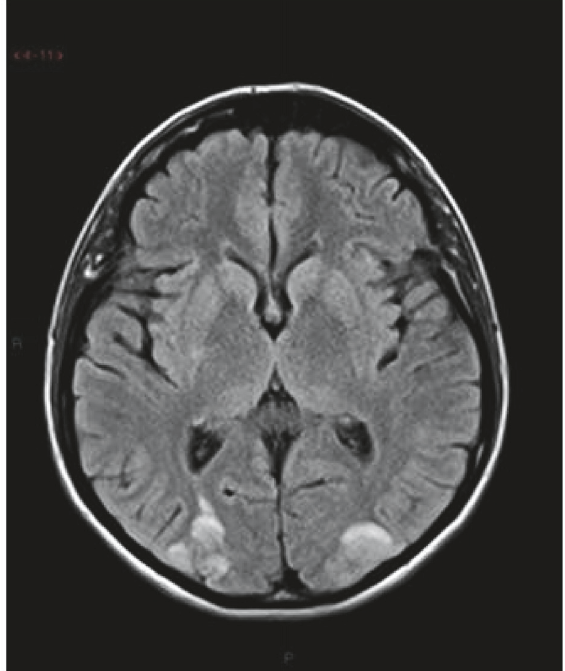
Figure 1: Axial FLAIR magnetic resonance images demonstrated bioccipital foci of high signal intensity involving the cortex and subcortical white matter.